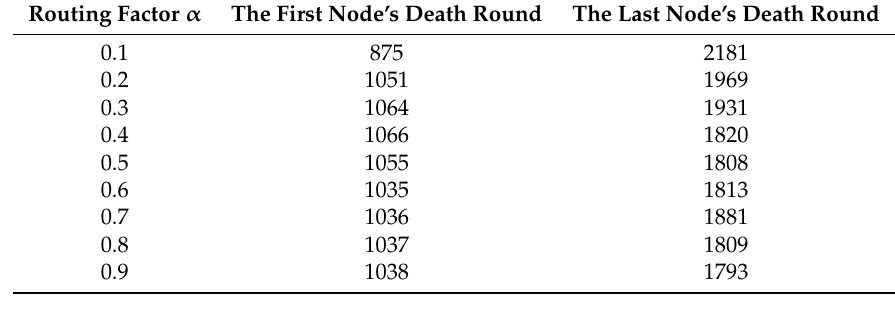
Table 3. A comparison of the first and last node’s death round in heterogeneous networks with different routing factor α .